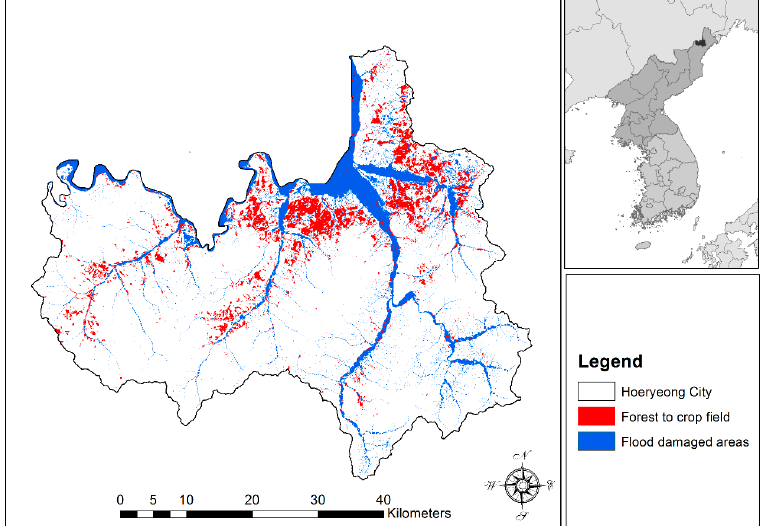
Figure 7. Flood-damaged areas map with land-use change.